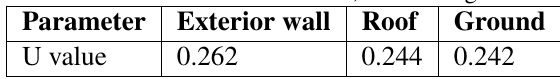
Table 6 U value of exterior walls, roofs and